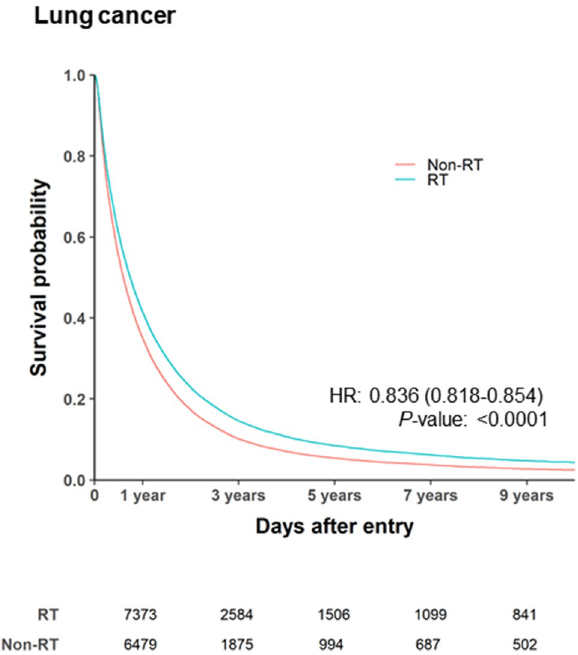
Figure 3. Cox regression survival analyses for lung cancer. Cox proportional hazards model adjusted for age, sex, CCI, chemotherapy use, surgery use, diagnostic year, and primary tumor location. HR hazard ratio, Non-RT Non-radiotherapy, RT radiotherapy. Created using SAS software (version 9.4; SAS Institute Inc., Cray, NC, USA).